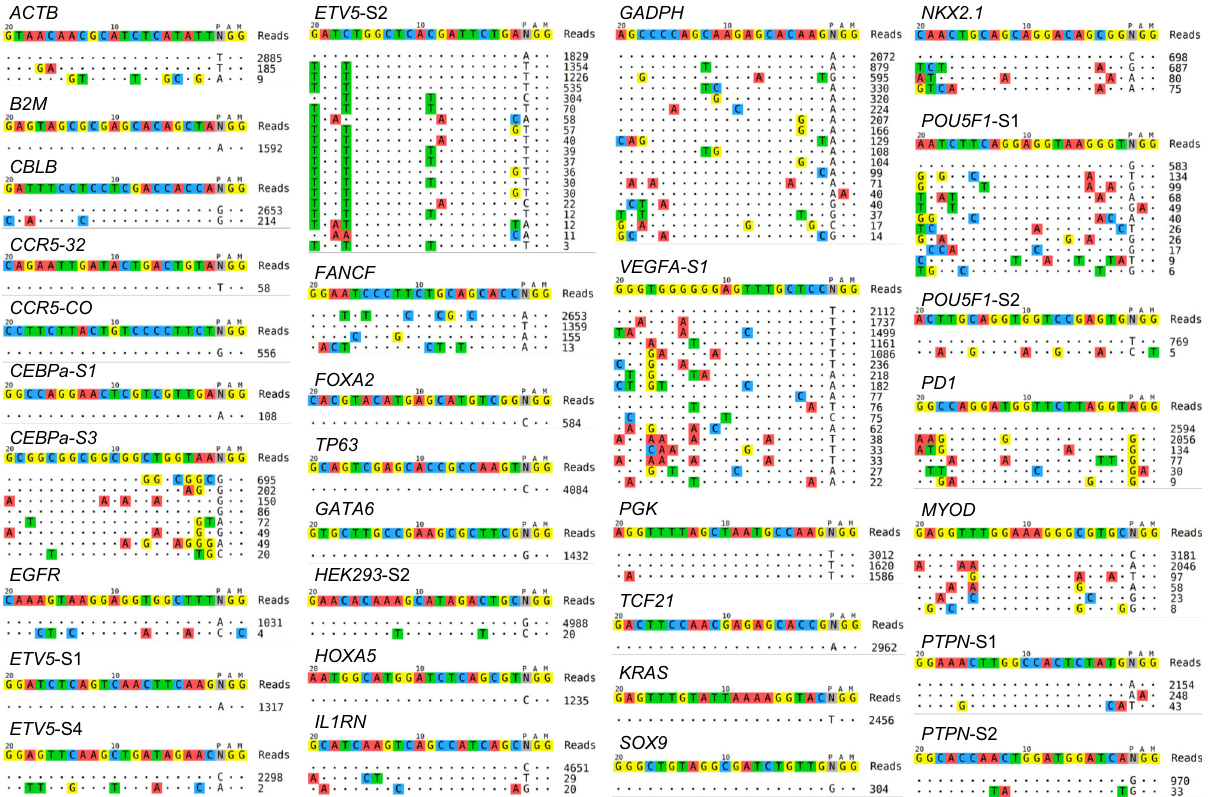
Fig. 3 Tag-seq identi fi es off-target cleavages induced by Cas9-nuclease in a large-scale manner. Tag-seq pro fi ling the off-target sites induced by Sp Cas9 with 31 sgRNA in a single transfection. HEK293T cells were transfected with the donor Tag-oligo, Sp Cas9 and a pool mix of 31 sgRNA. Cells were harvested three days after transfection, and genomic DNA was extracted for library construction and then sequenced. All the off-target cleavages of the 31 sites can be parallelly pro fi led by bioinformatics analysis. The donor DNA sequences and the sgRNAs used in this study are shown in Supplementary Table 3 and Supplementary Data 2.